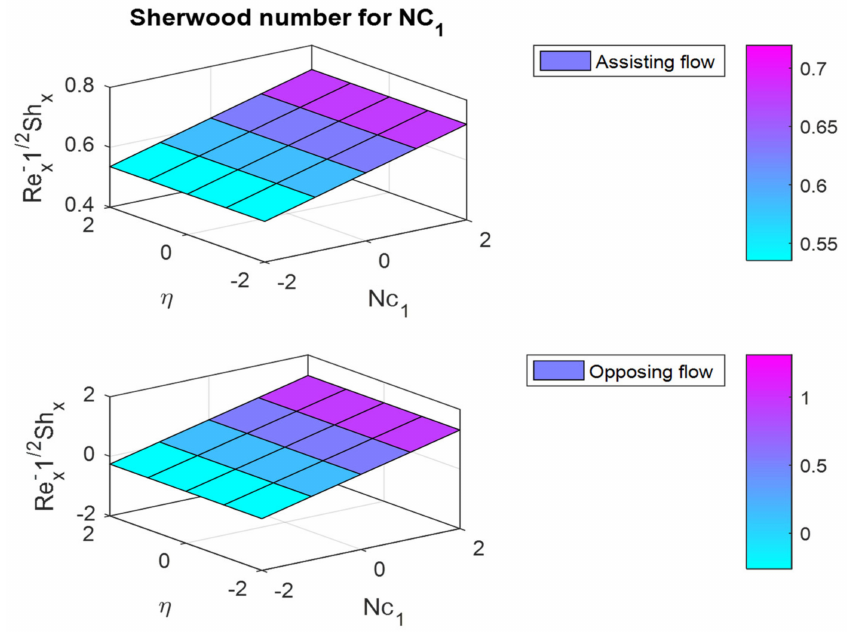
Figure 33. Surface plots for the φ (cid:48) ( 0 ) for dissimilar values of Nc 1 . (cid:48)(cid:48) ( The f 0 ) , θ (cid:48) ( 0 ) and φ (cid:48) ( 0 ) plots for various values of the buoyancy ratio parameter Nc 2 are shown in Figures 34–36. Figure 34 shows that when Nc 2 increases, the skin friction coefficient decreases at a rate of − 0.31689 ( λ > 0 ) or − 0.32663 ( λ < 0 ) . For assisting and opposing flow, the Nusselt and Sherwood numbers escalate rates of 0.019164 and 0.022813, and 0.022813 and 0.026919,